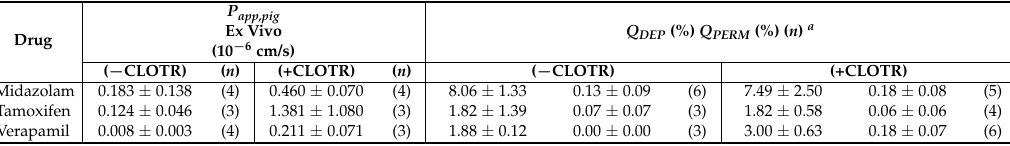
Table 5. The apparent drug permeability coefficients, P app, pig and Q DEP and Q PERM , in the jejunum for drug substrates of CYP3A4 in the presence (+CLOTR) and absence ( − CLOTR) of the CYP3A4 inhibitor,